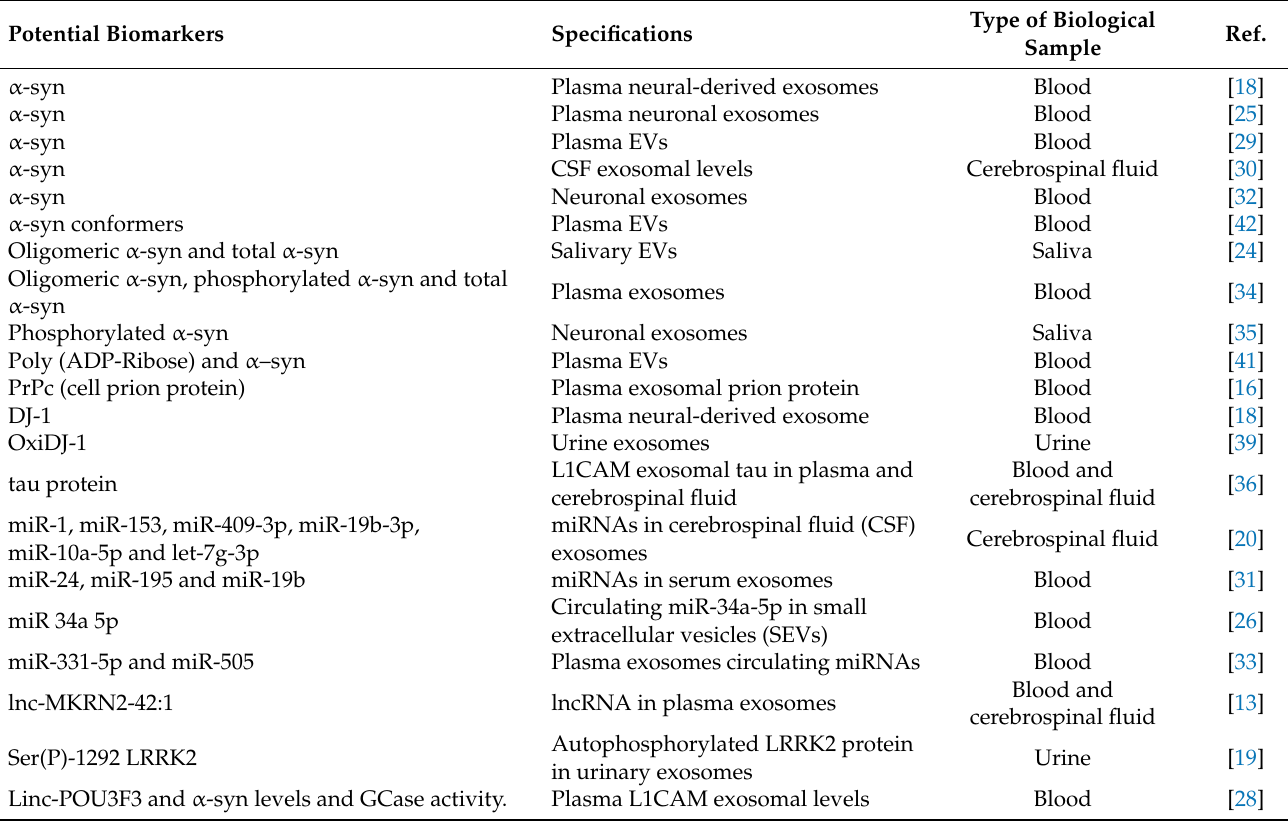
Table 2. Summary of potential biomarkers in the analyzed